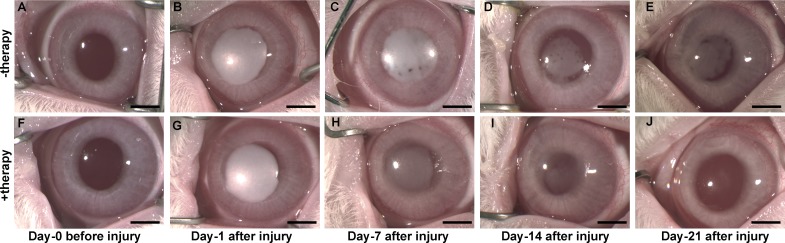
Biomicroscopy images before and after alkali-induced corneal injury of rabbit eyes that did not receive BMP7+HGF treatment (A–E) and those that received BMP7+HGF treatment (F–J). Dense corneal opacity developed by day 1 after induction of alkali injury (B, G). On day 14 and day 21 post injury, corneas that received PEI2-GNP–mediated BMP7+HGF eyes showed a significant reduction of opacification (H–J) as compared to the level of opacification in corneas that received naked vector (C–E). Scale bar: 2 mm.